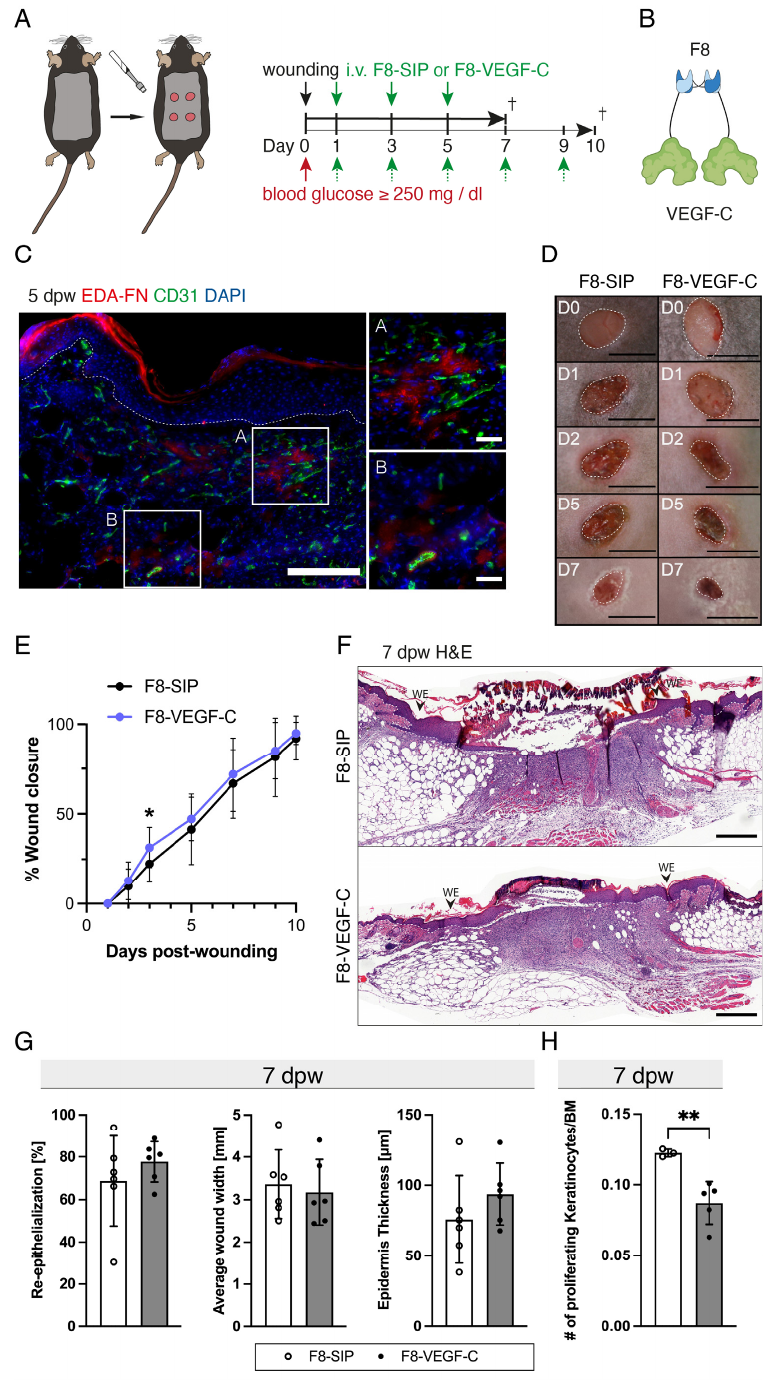
Figure 5. The F8–VEGF-C fusion protein is specific for regenerating tissue and improves wound morphometry. ( A ) Full-thickness excisional wound healing model in db/db mice. Blood glucose measurement prior to wounding on day 0 (inclusion criteria: blood glucose ≥ 250 mg/dL). Injection